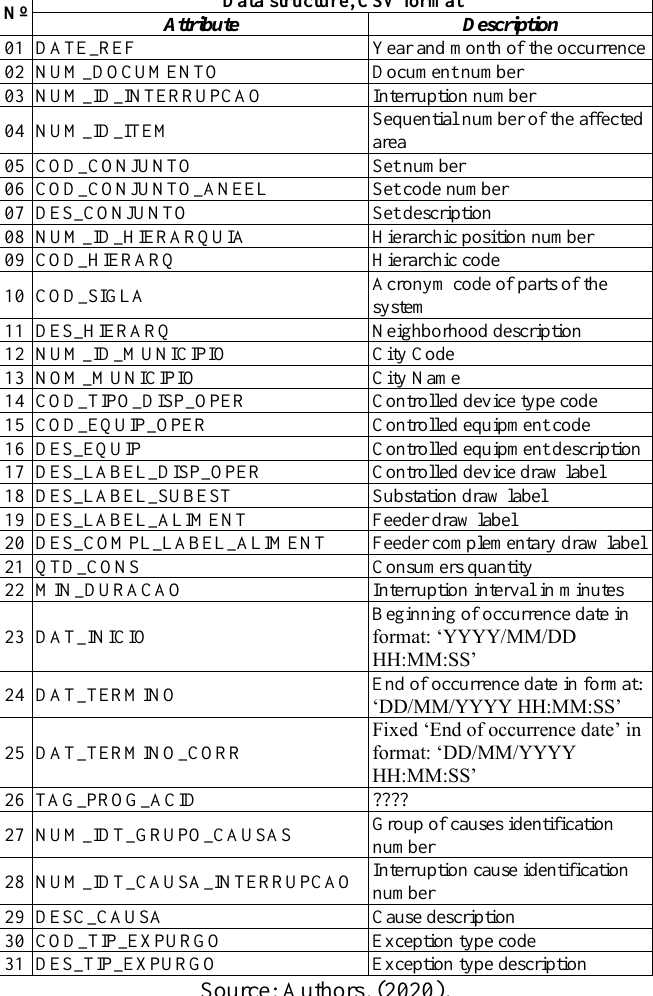
Table 1: PREVDEC_INTERRUPTIONS_2017.CSV